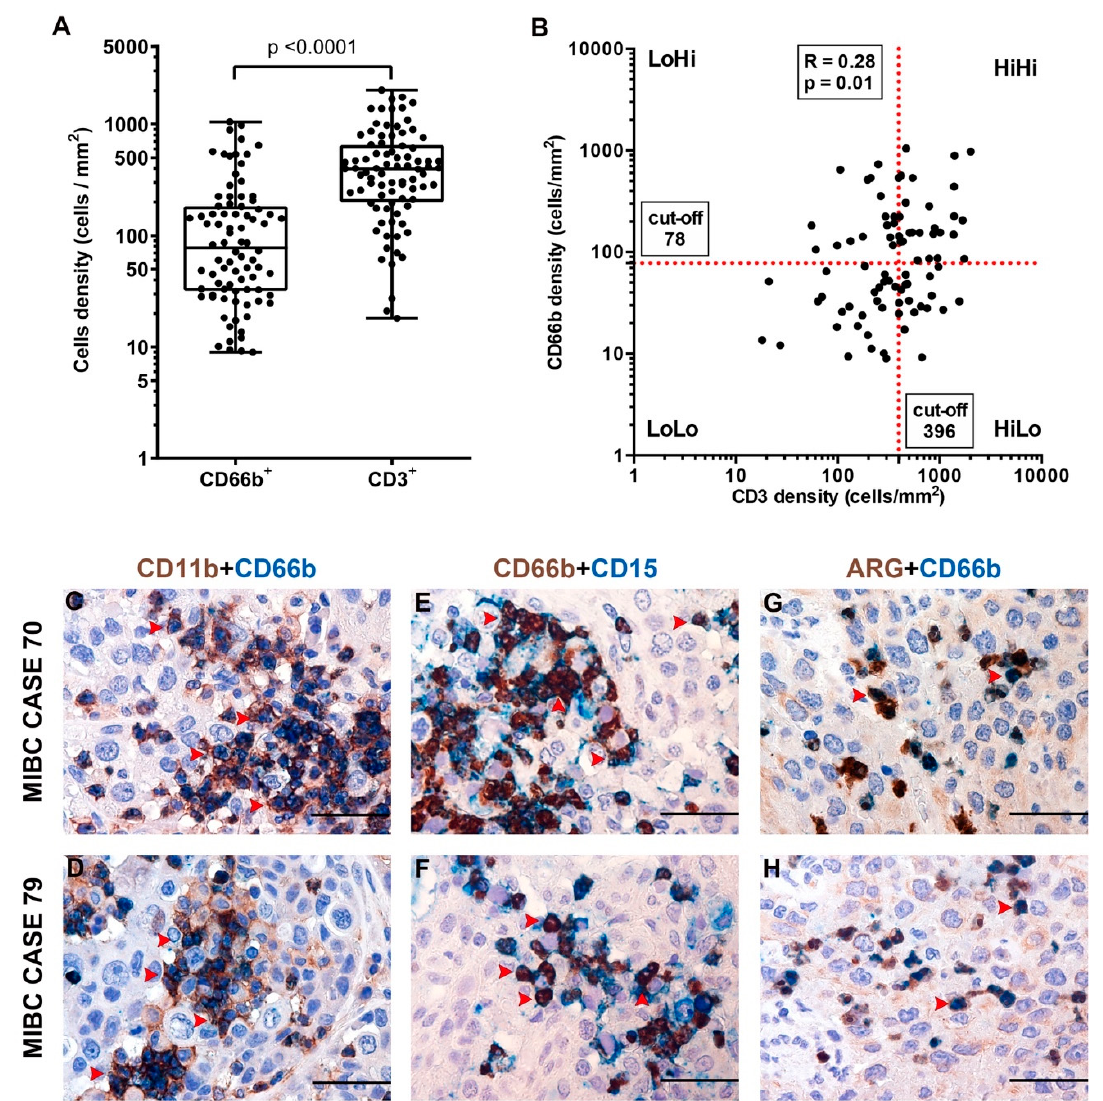
Figure 2. Density of CD66b + TAN and CD3 + T cells and phenotype of TAN in human MIBC. Dot plots indicating the density of CD66b + TAN and CD3 + T cells in the MIBC cohort is reported in ( A ); the correlation between the two variables is illustrated in ( B ). Sections are from two representative MIBC cases (case #70 in C , E and G ; case #79 in D , F and H ) and stained as labeled, illustrating CD66b + TAN co-expressing neutrophil markers: CD11b, CD15 and ARG. Sections are counterstained with hematoxylin. Magnification 400× (scale bar 50 micron).